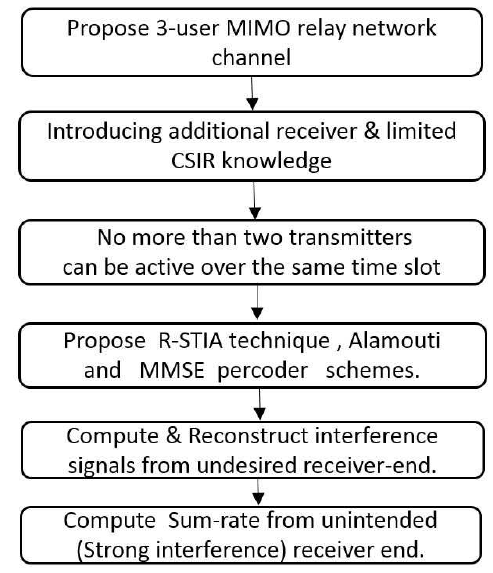
Figure 3. Proposed optimization